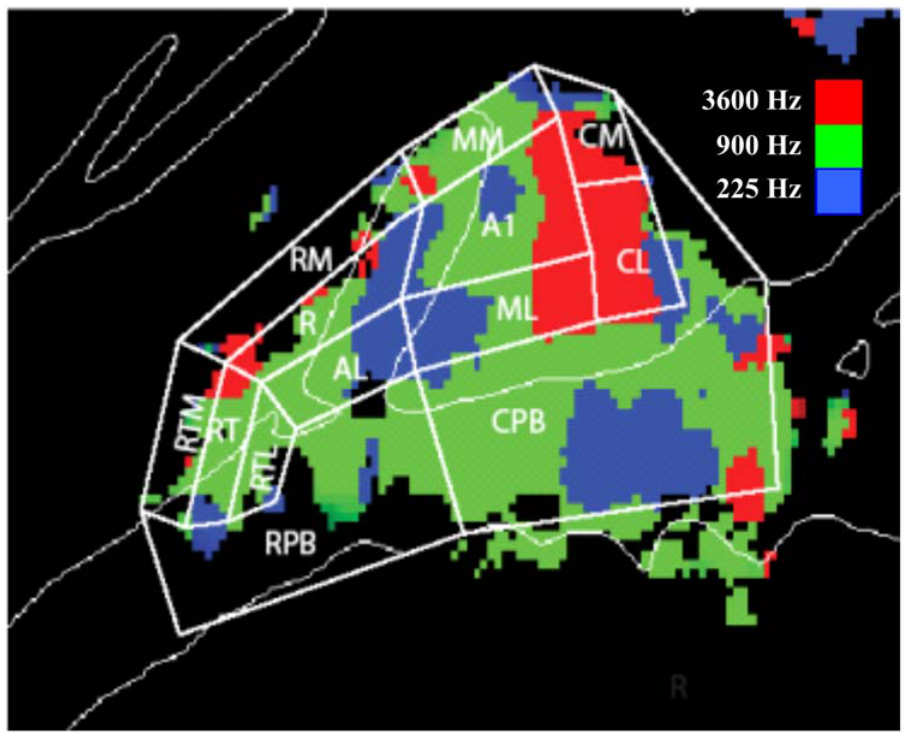
Figure 14. A schematic model of human auditory cortical fields. Schematic representations of primate auditory cortical fields (Kaas & Hackett, 2000) superimposed on frequency-specific activation patterns in human auditory cortex. Field borders were estimated based on similarities in tonotopic organization observed in the current study and in fMRI studies of macaque auditory cortex (Petkov et al. 2006, Kayser et al. 2007). Colors show frequency tuning of grand mean activations averaged over subjects, hemispheres, image acquisition parameters, tone location and tone intensity. Red=3600 Hz, green=900 Hz, blue=225 Hz. A1=primary auditory cortex; R=rostral, T=temporal, M=middle; A=Anterior; L=lateral, C=caudal,